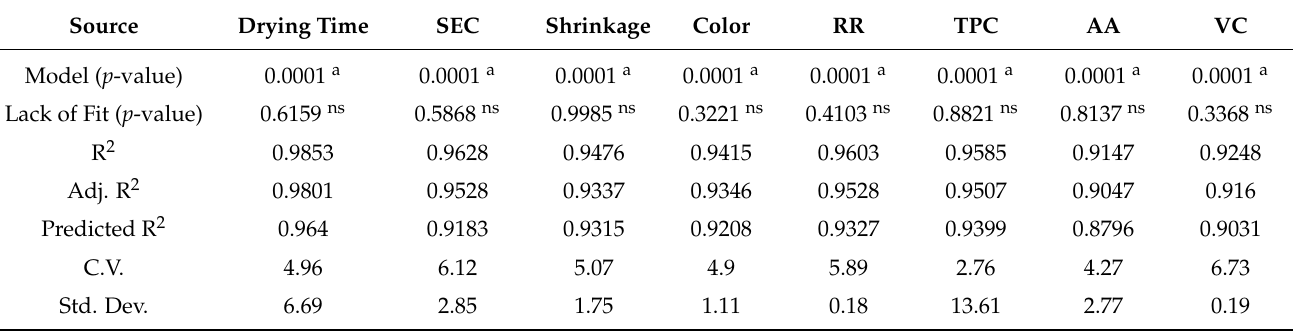
Table 4. Statistical values fitted for dependent variables by response surface